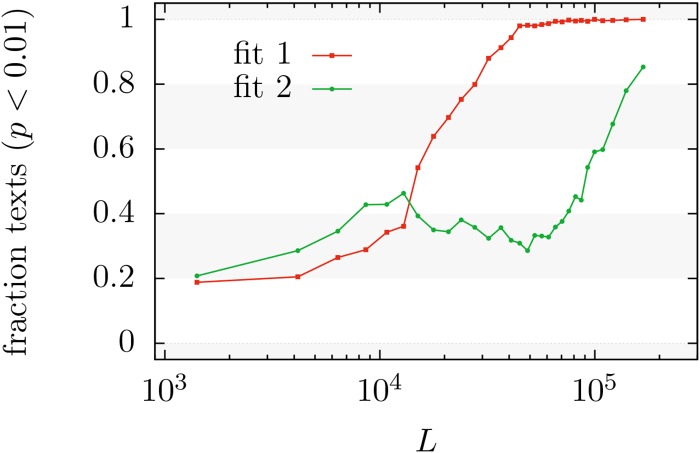
Number of texts with p-value near zero (p < 0.01) in different ranges of L divided by the number of texts in the same ranges, for the fits of distributions f1 and f2.Values of L denote the geometric mean of ranges containing 1000 texts each. The higher value for the fit of f1 (except for L below about 13000 tokens) denotes its worst performance.